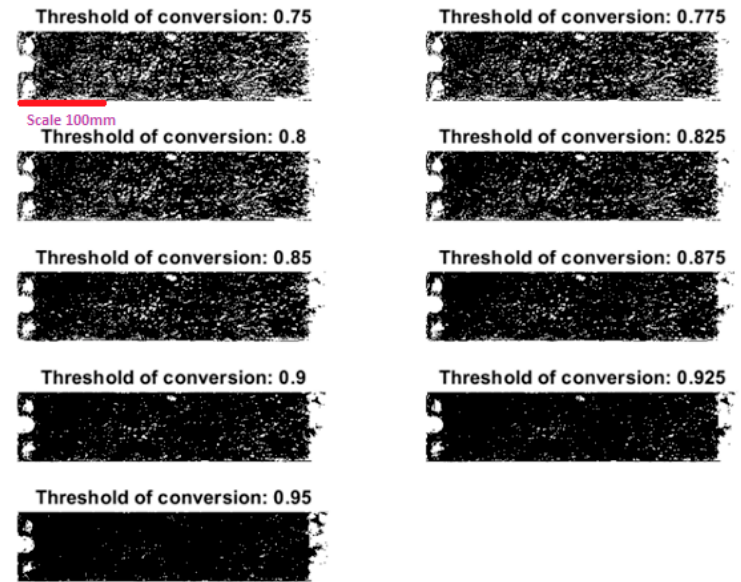
Figure 7. Effect of thresholding on a scanned image.